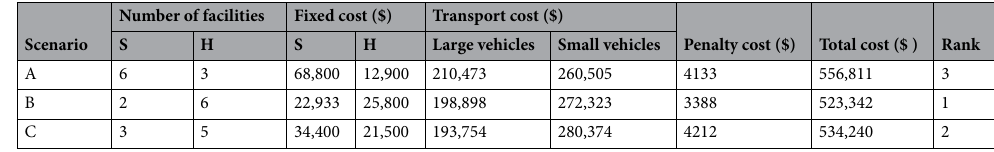
Table 8. Results from ZOLD model via the